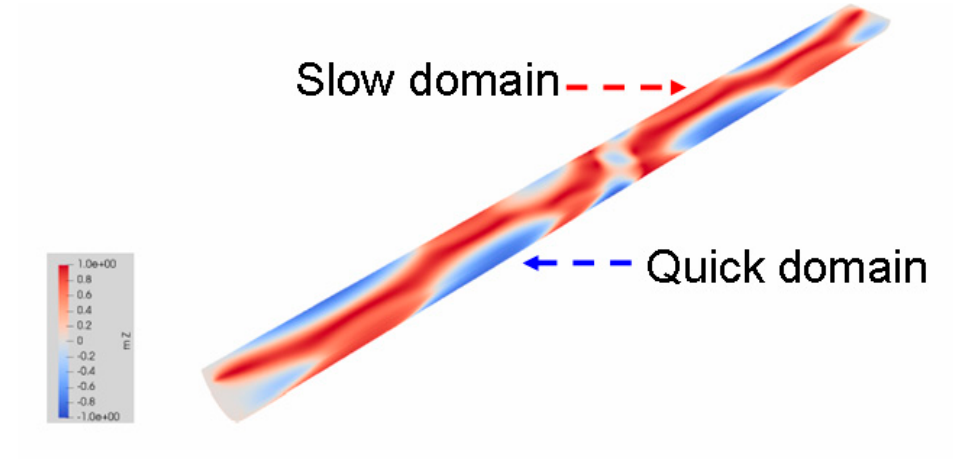
Figure 8. Calculated domain structure presented as half-tube.